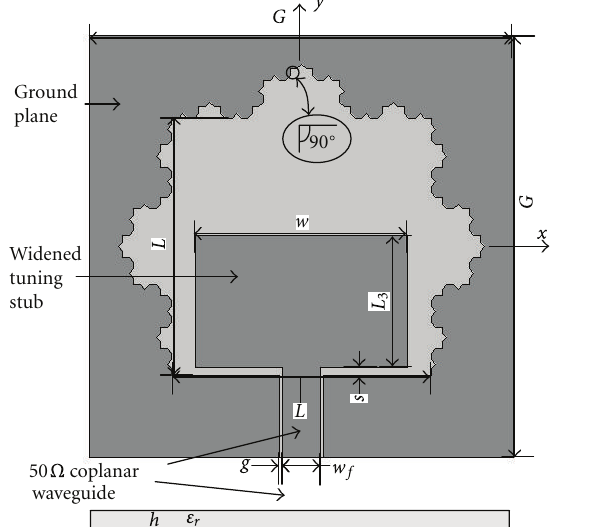
Figure 1: Geometry of the proposed antenna.